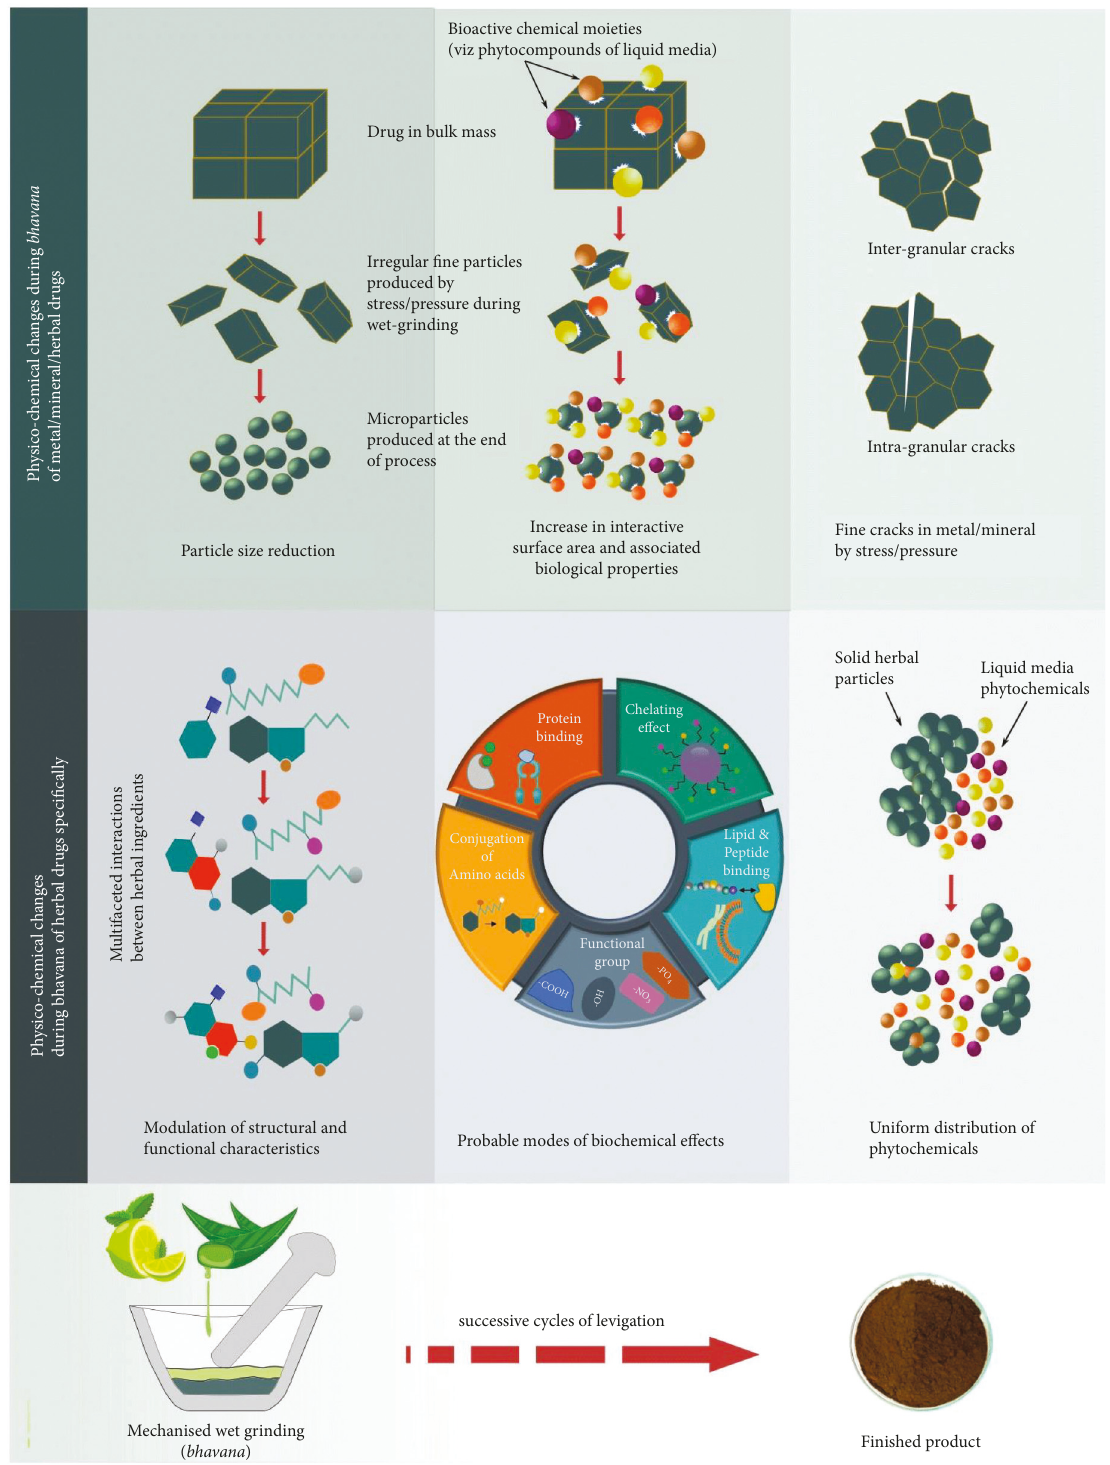
Figure 4: Illustration of probable physicochemical changes undergoing herbal/mineral/metal-based drugs during